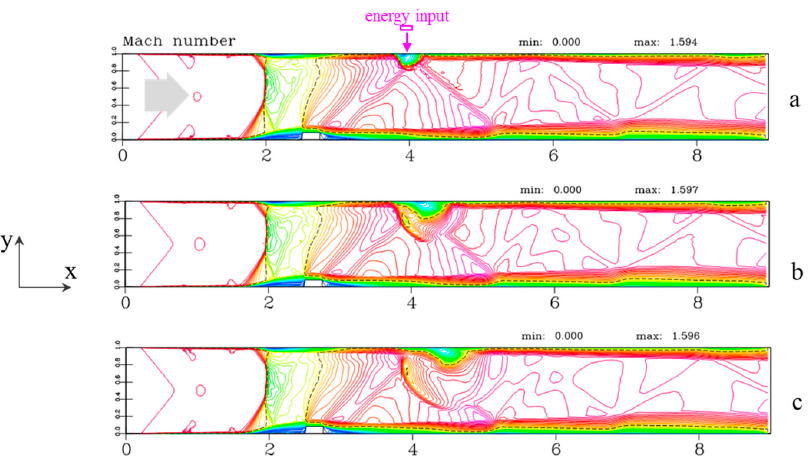
Figure 9. The Mach number field after the energy input in simulations at times 2.5 µ s ( a ), 10 µ s ( b ), 20 µ s ( c ). The energy input is 0.29 J. The energy input volume is 90 mm 3 ; the total time of the energy input is 600 ns. The Mach number of the incoming flow is 1.40. The zero-time corresponds to the beginning of energy input. Sonic lines (M l = 1) are shown in dashed lines.